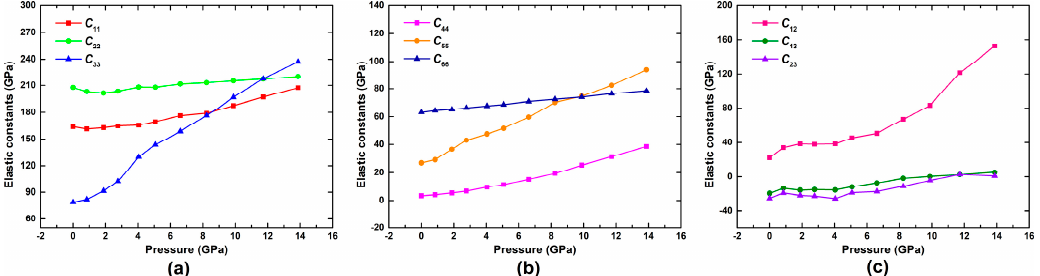
Figure 3. The calculated elastic constants ( C ij ) of pyrophyllite [Al 4 Si 8 O 20 (OH) 4 ] under different pressures. ( a ) Calculated value of C 11 , C 22 and C 33 under given pressures; ( b ) Calculated value of C 44 , C 55 and C 66 under given pressures; ( c ) Calculated value of C 12 , C 13 , and C 23 under given pressures.